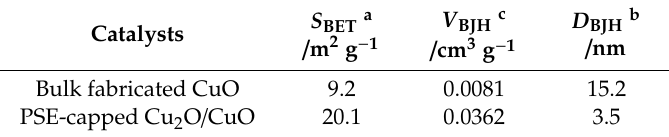
Table 1. Structural parameters for bulk fabricated CuO and PSE-capped Cu 2 O/CuO materials.